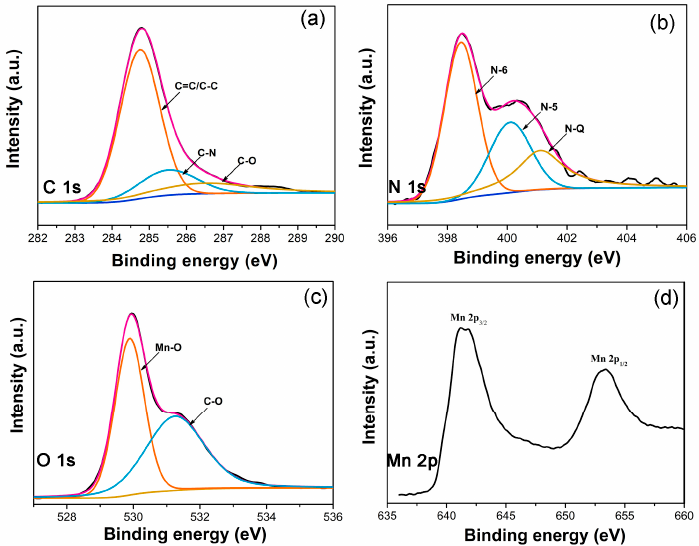
Figure 3. Peak-fitting X-ray photoelectron spectroscopy (XPS) spectra of ( a ) C1s ( b ) N1s ( c ) O1s and ( d ) Mn 2p for MnO@CFs.